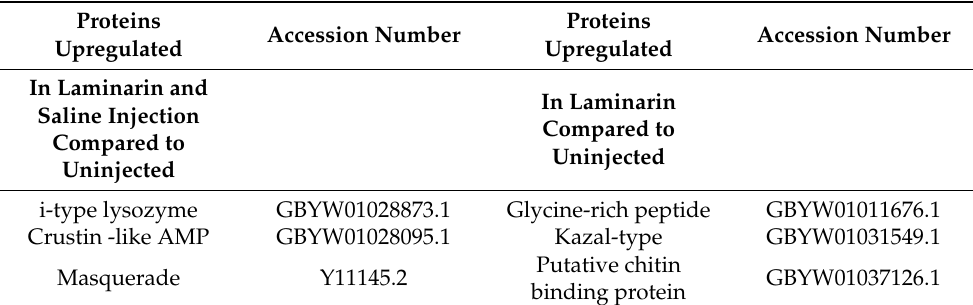
Figure 4. Differentially expressed proteins after laminarin injection. Volcano plot showing differen- tially expressed proteins in hemocytes six h after laminarin injection compared to saline ( A ) and to uninjected crayfish ( B ). Significantly higher expressed proteins are shown in blue color and lower expressed proteins are shown in red color. The red frames indicate significant according to our criteria (Log2Ratio > 0.58, –log2 p value > 5). Table 3. Specifically, upregulated proteins after laminarin injection compared to saline injection and uninjected controls, respectively. Accession number in the transcriptome database for P. leniuscu- lus (BioProject PRJNA259594), TSA: GBYW01000001:GBYW01075939 is given, limit Fold change Log2ratio < 0.58, p (–log) >